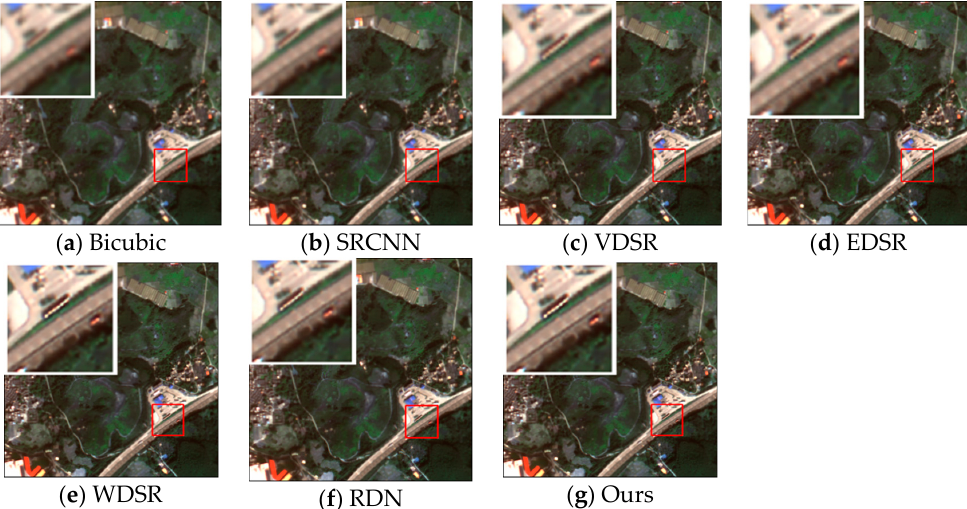
Figure 11. Qualitative comparisons of our model with other methods at the scale of × 3 on the GF-2 multispectral channels test set at the original scale displayed with red, green, and blue